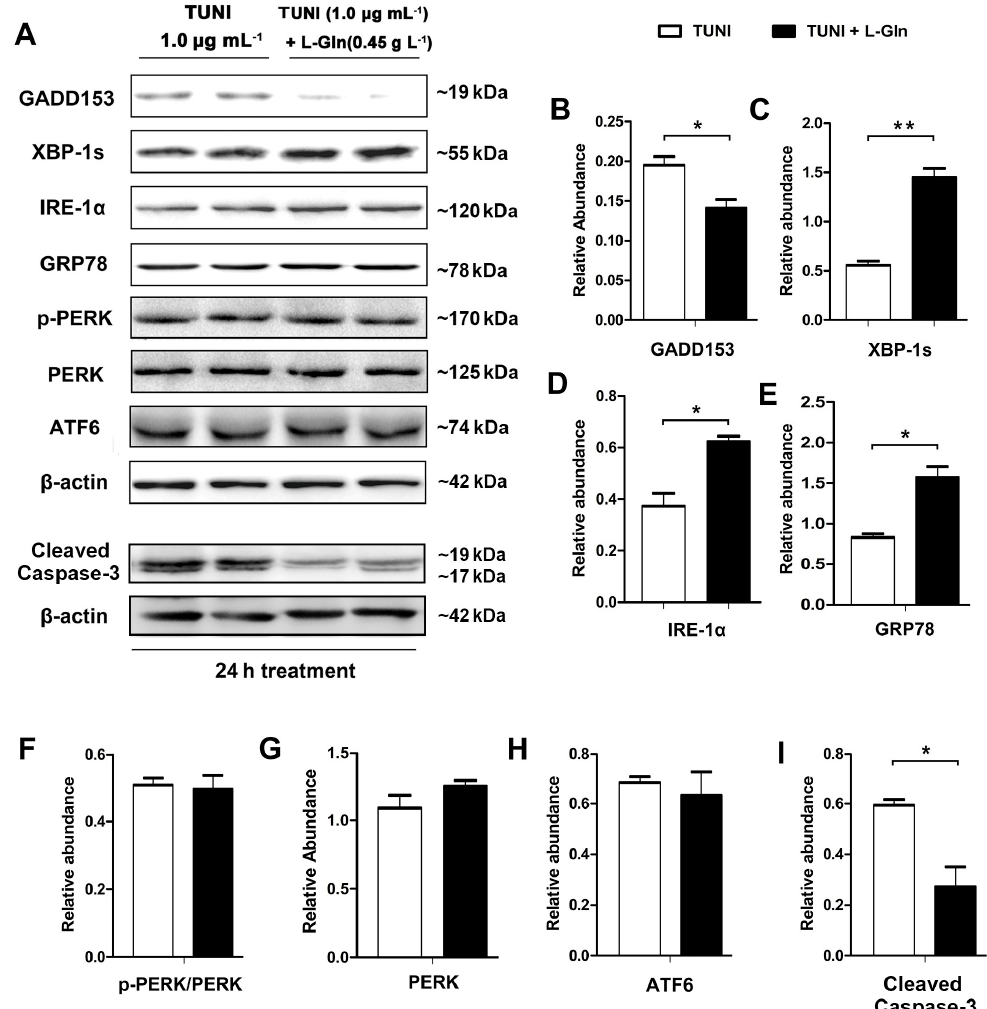
Figure 4. L -glutamine enhances IRE1 α -XBP1 axis in ERS-responsive cells. In basic DMEM, cells were treated with 1.0 µ g mL − 1 TUNI or a combination of 0.45 g L − 1 L -glutamine and TUNI for 24 h. ( A ) Expression of unfolded protein response (UPR) pathway proteins and cleaved caspase-3, respectively, was determined using the Western blot; two representative protein bands from three independent experiments are shown; ( B ) Relative abundance of GADD153; ( C ) Relative abundance of XBP-1s; ( D ) Relative abundance of IRE-1 α ; ( E ) Relative abundance of GRP78; ( F ) Relative phosphorylation level of protein kinase RNA-like endoplasmic reticulum kinase (PERK) (phospho-PERK (p-PERK)/total PERK); ( G ) Relative abundance of total PERK; ( H ) Relative abundance of ATF6; ( I ) Relative abundance of cleaved caspase-3. β -actin was assessed as a loading control. Data given as means ± SDs for the three independent experiments (* means under T test, p < 0.05, ** means under T test, p < 0.01).